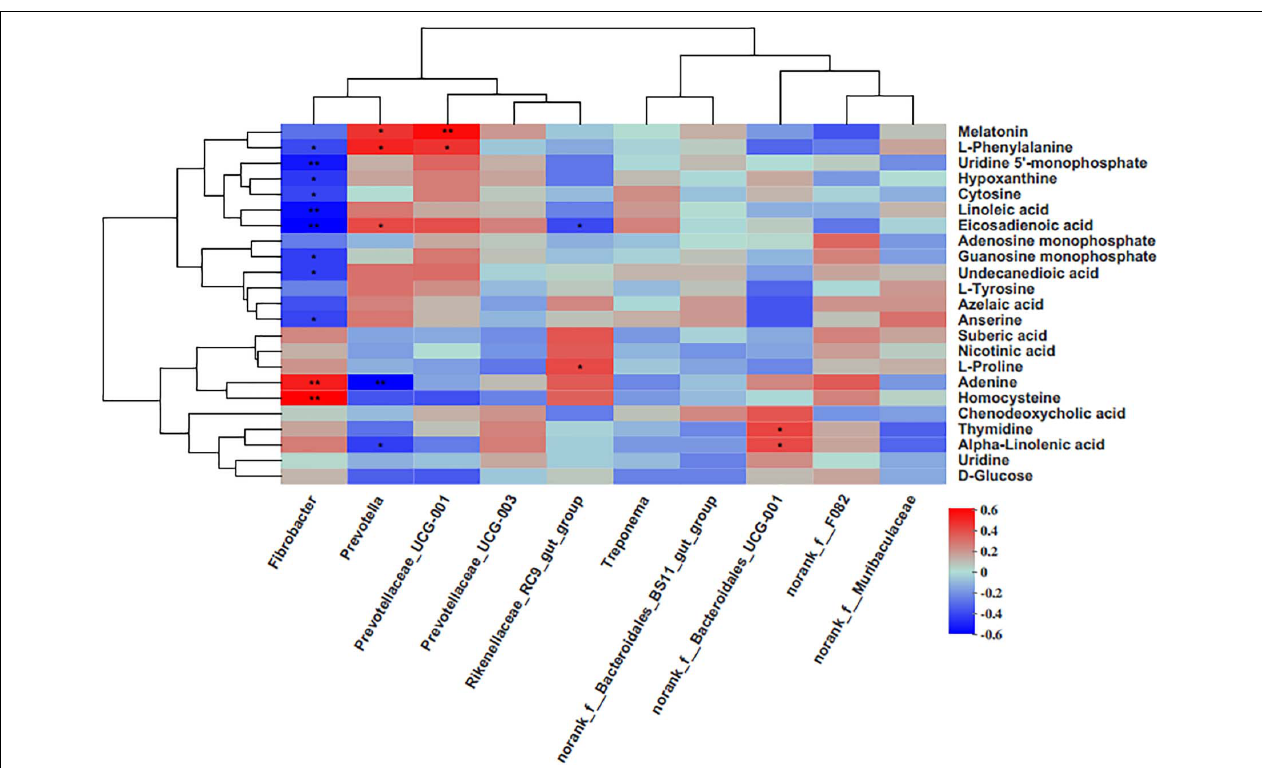
FIGURE 5 | Correlation matrix between the genera level and the ruminal differential metabolites (used in Table 1 ). Each column in the graph represents a genus, each row represents a metabolite, and each lattice represents a Pearson correlation coefficient between a metabolite and a component. Red represents a positive correlation, while blue represents a negative correlation. * p < 0.05; ** p <